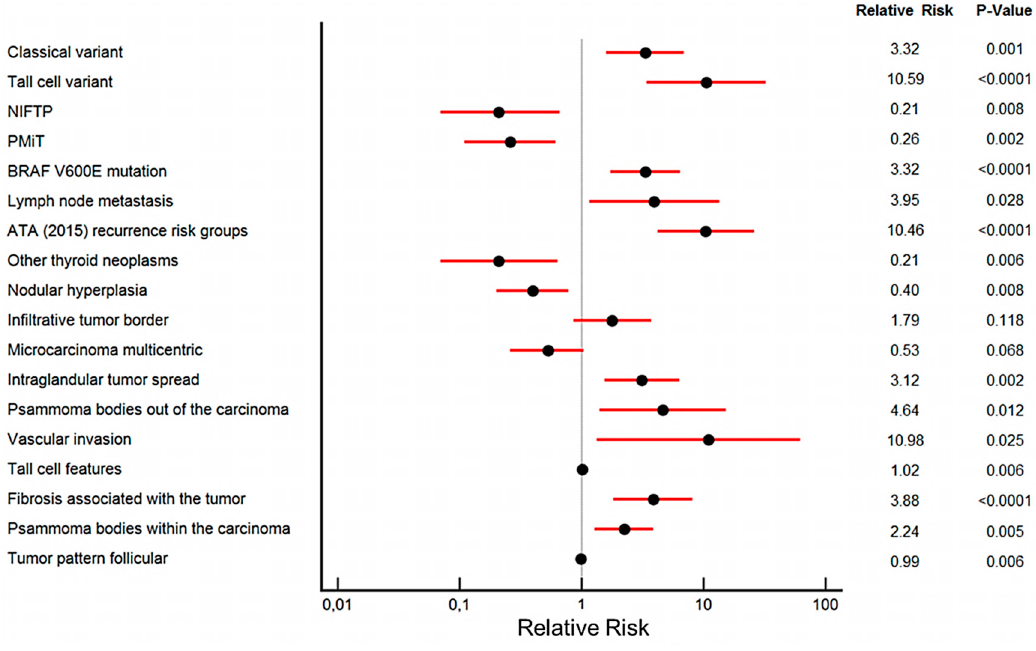
Figure 4. Multinomial logistic regression analysis comparing the four microcarcinoma groups (group D tumors used as a reference).